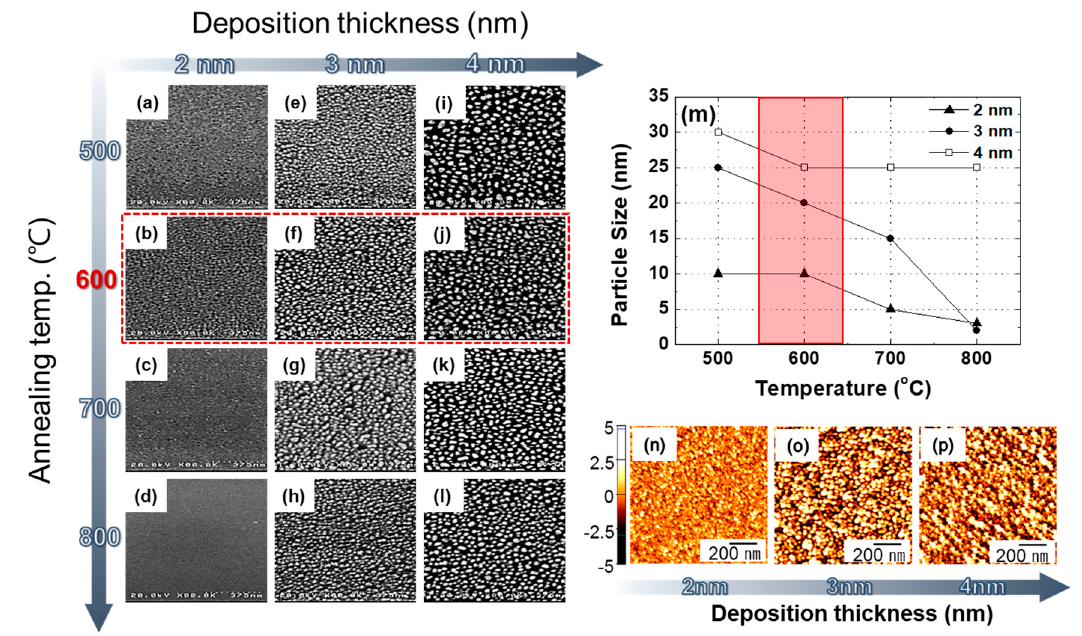
Figure 2. SEM images of Pt NPs with different deposition thicknesses and annealing temperatures.